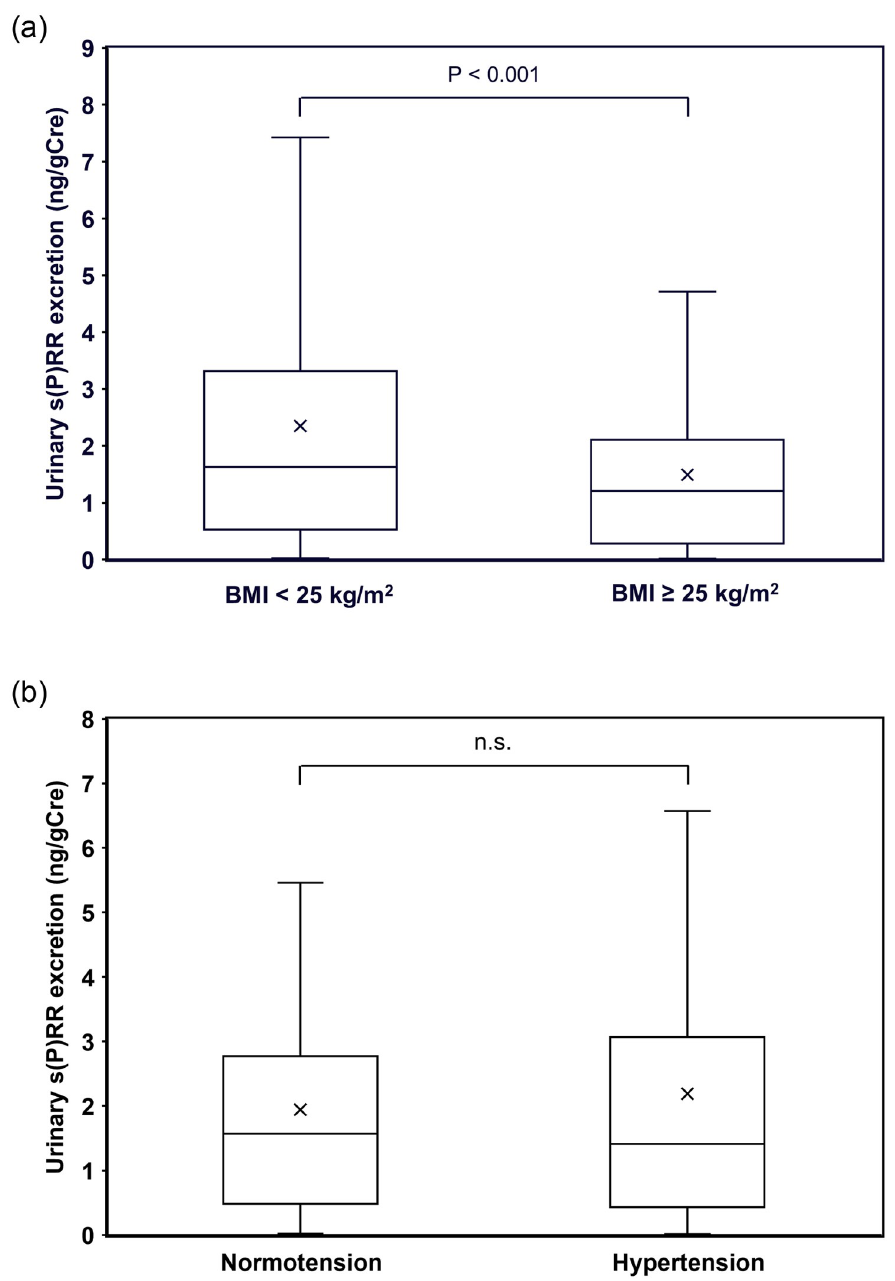
Fig 2. Comparisons of urinary s(P)RR excretion between patients with and without obesity (a) and those with and without hypertension (b). s(P)RR, soluble (pro)renin receptor; BMI, body mass index.